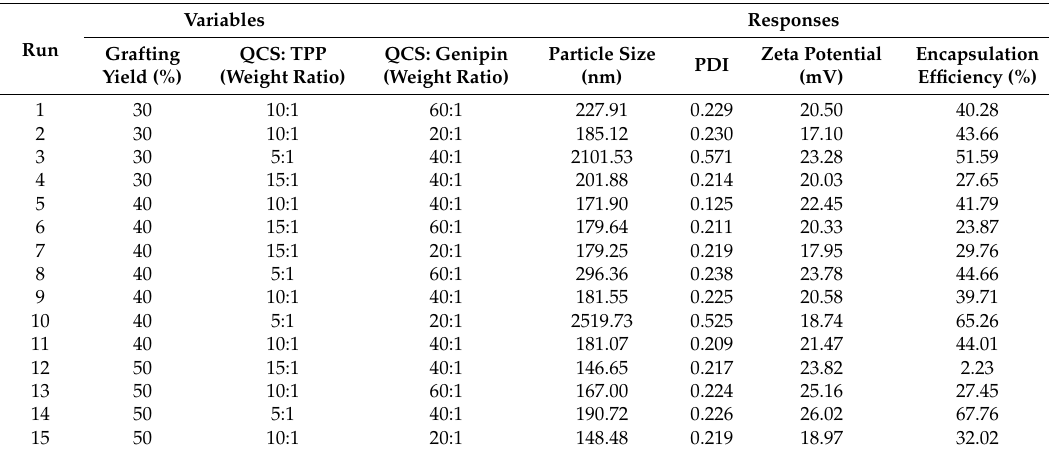
Table 3. Experimental runs and observed values of responses for